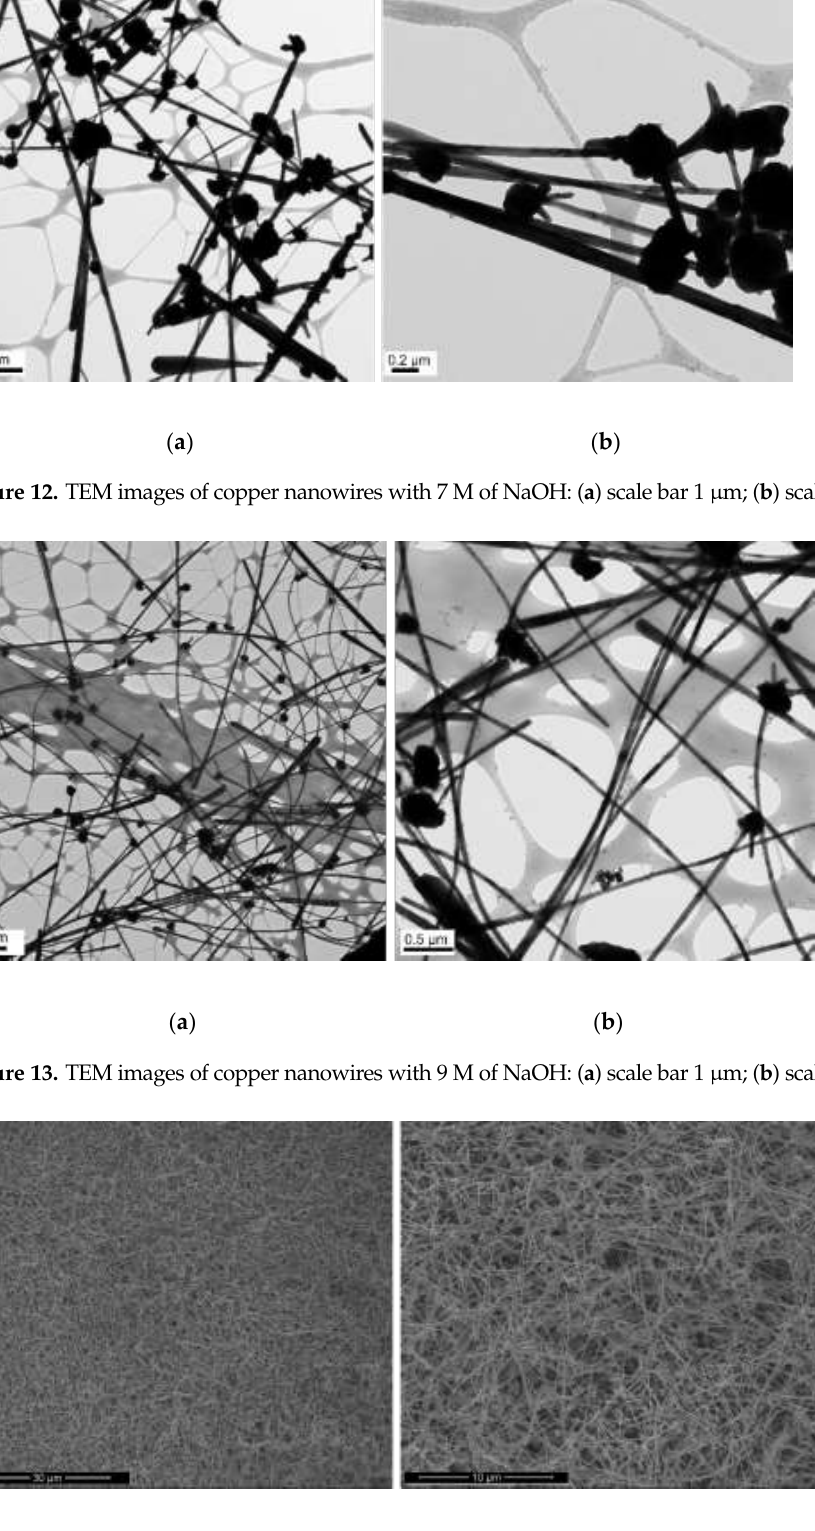
Figure 11. TEM images of copper nanowires with 5 M of NaOH (scale bar 0.5 µm).